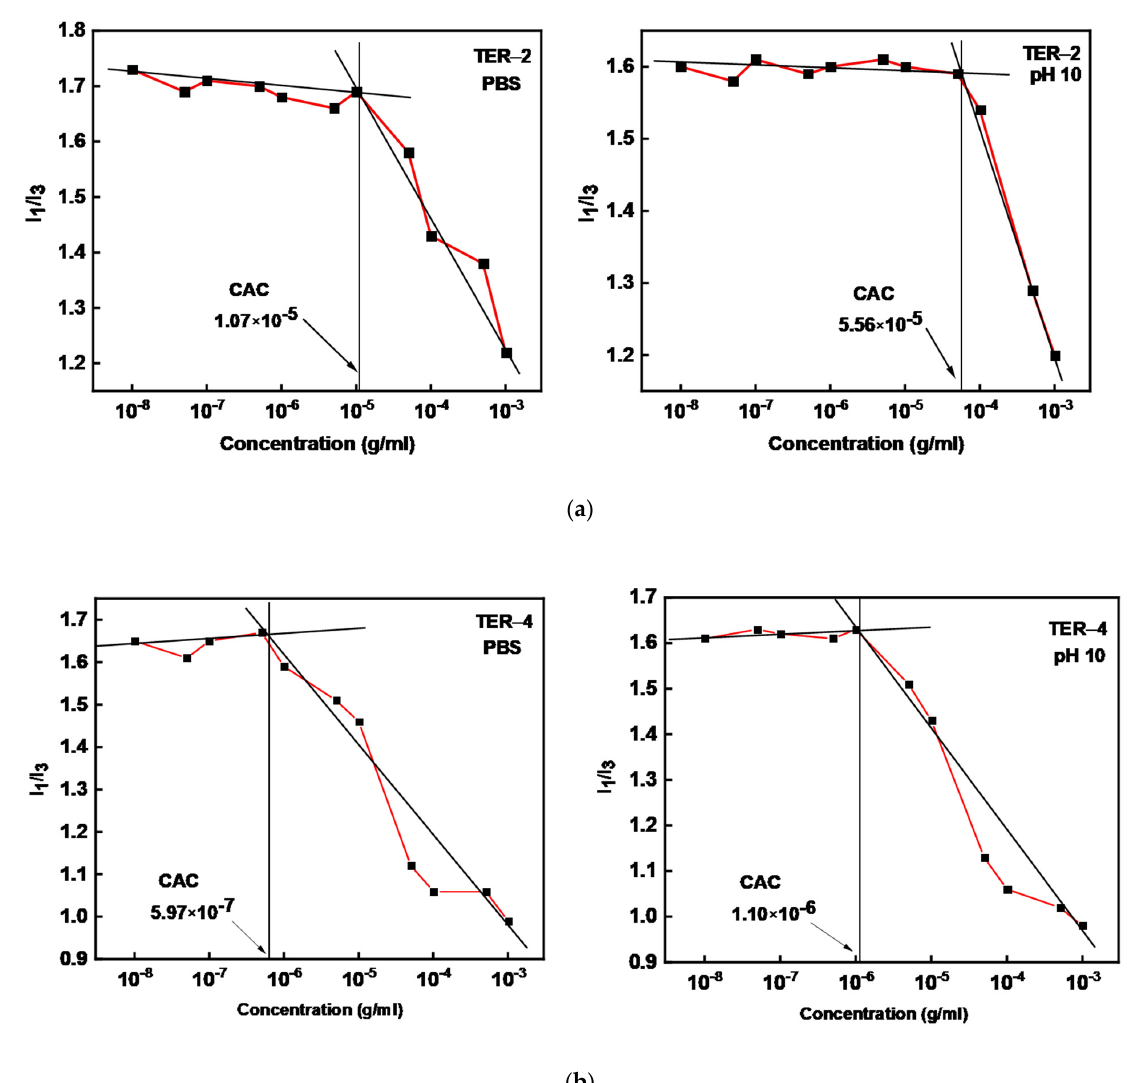
Figure 3. ( a ) CAC determination for TER-2 terpolymer; ( b )TER-4 terpolymer in PBS ( left ) and pH = 10 ( right ), respectively. Red lines: are a guide to the eye, connecting all experimental points; Black lines: show how CAC was determined by the intersection point.